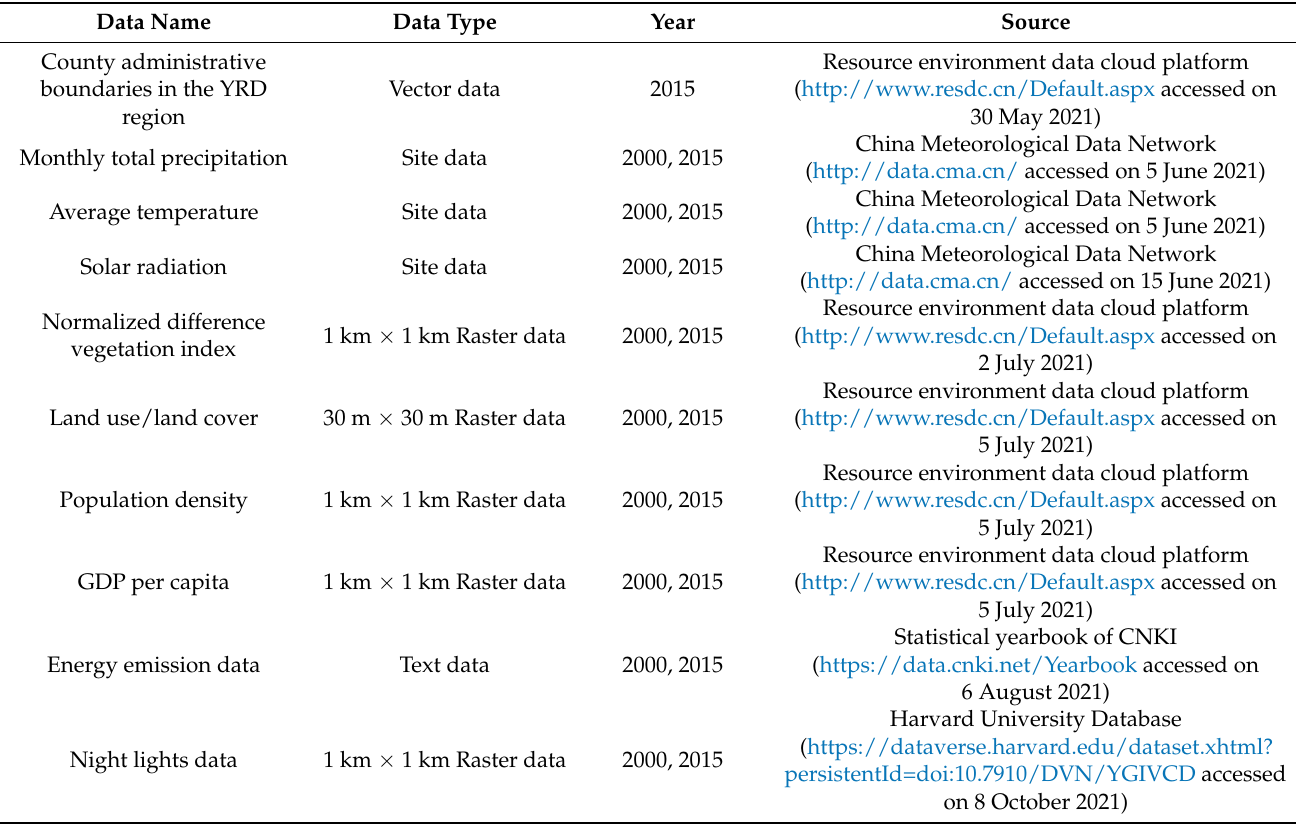
Table 1. Data used in this